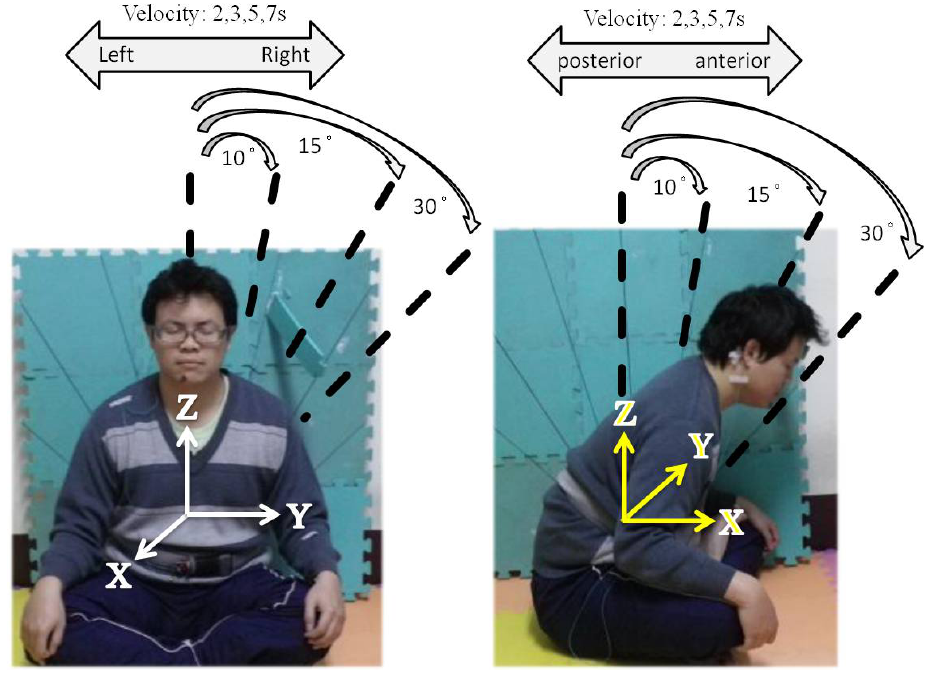
Figure 2. Left-to-right sway and anterior-posterior motion measurement